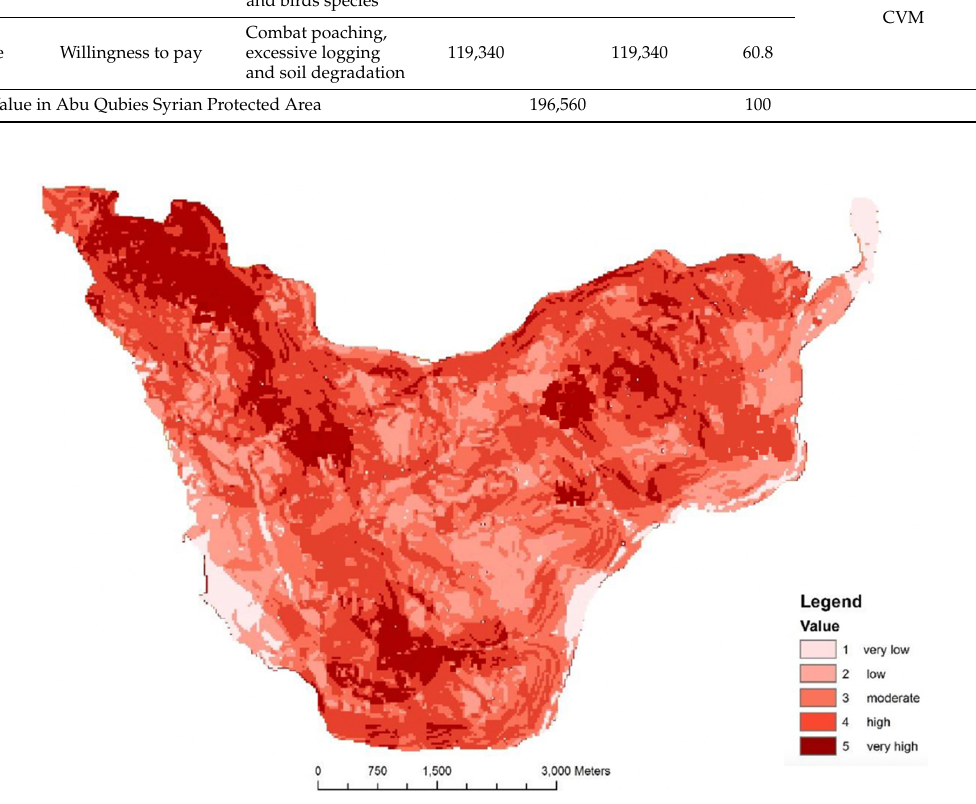
Figure 7. Graded color map representing Abu Qubies non-use values (existence—bequest).